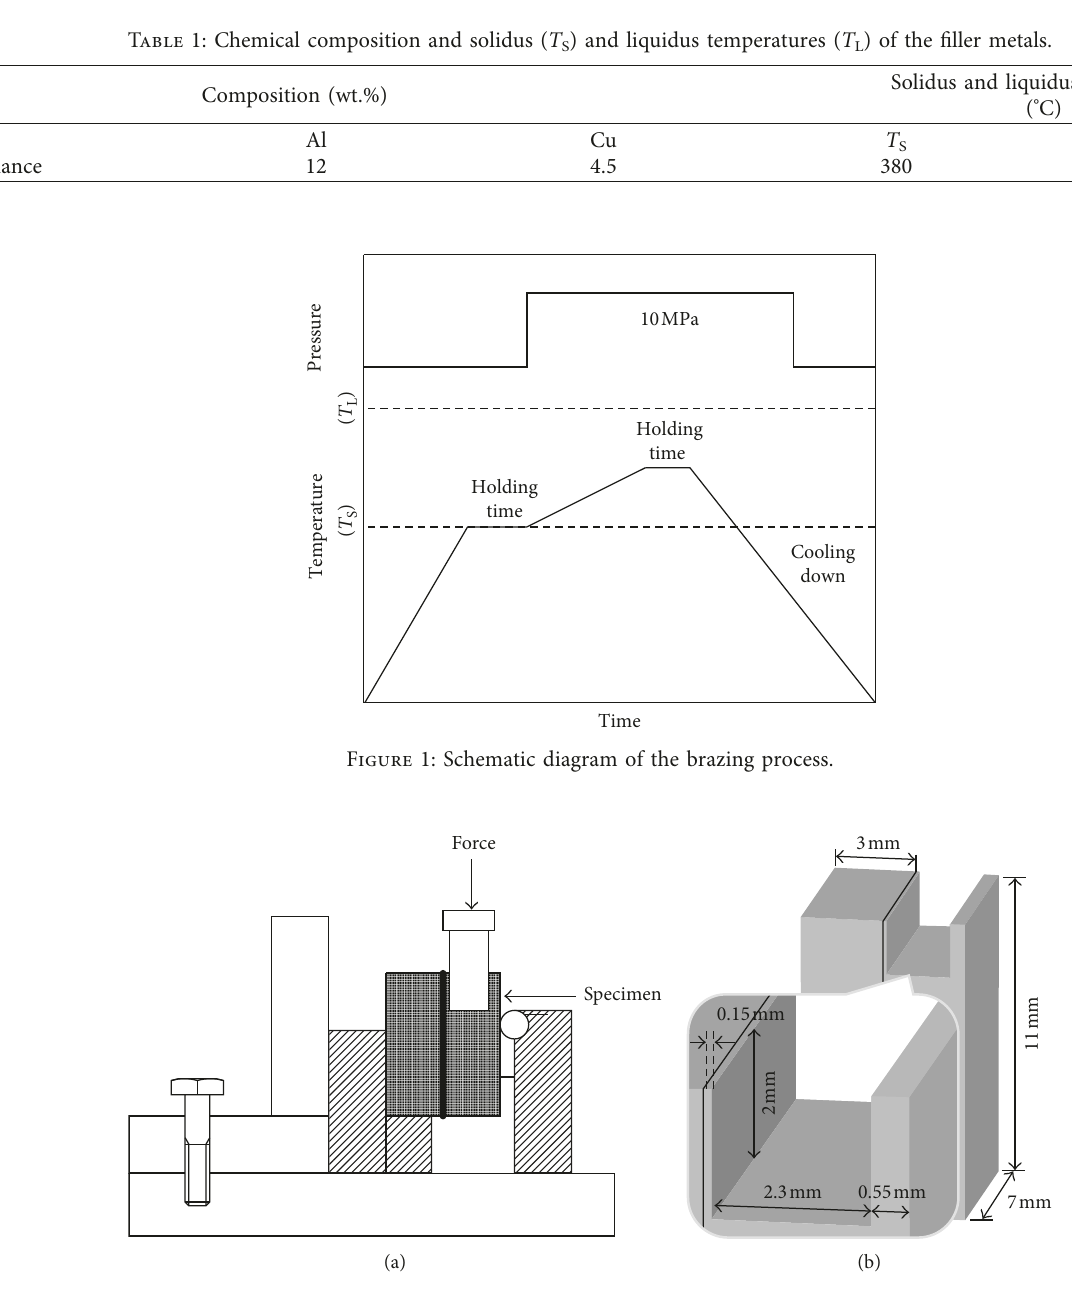
Figure 2: Schematic diagram of (a) shear test arrangement and (b) dimension of the shear specimen (bond line is shown by a thick line).